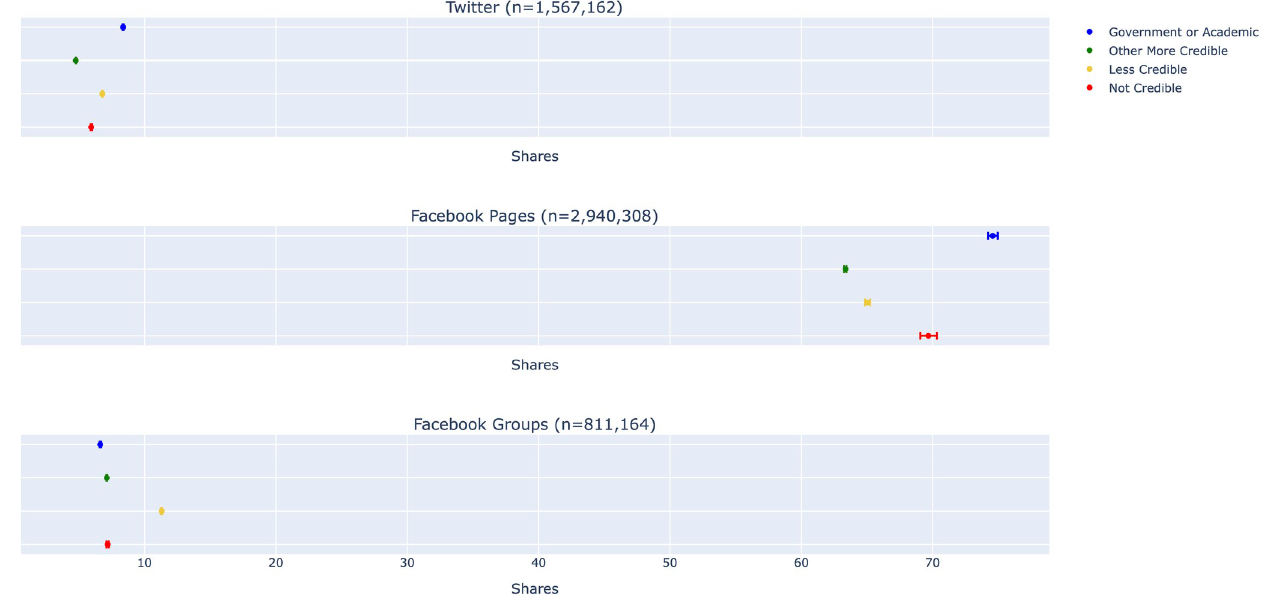
Fig 3. Average number of shares for each credibility category by platform, estimated using negative binomial